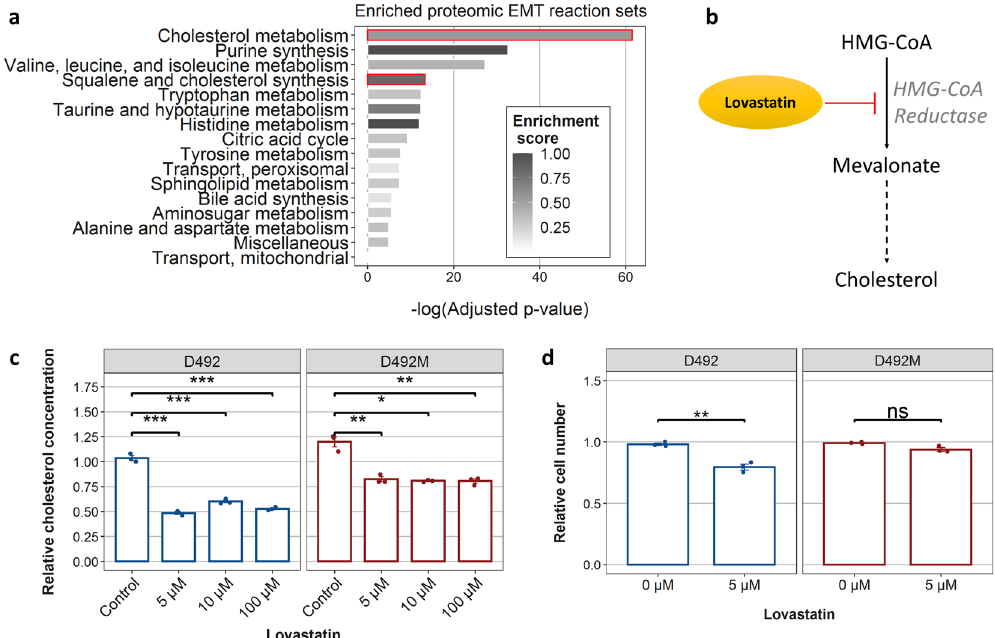
Fig. 4 Integrated analysis of all data-type based GSMMs reveals EMT-related differences in cholesterol metabolism. a Enrichment analysis of reactions that need alterations for the EPI to take on a MES fl ux phenotype in all proteomic GSMMs. This approach helps to identify reaction sets (i.e., families of pathways) which need to be altered for EMT-related changes in fl ux pro fi les. Reaction sets shown are ones with FDR- corrected p value less than 0.01. The scale (Enrichment score) represents the fraction of set reactions within the EMT reactions. The p values are FDR-adjusted p values from a hypergeometric test for enrichment of reaction sets. The two reaction sets highlighted in red are cholesterol- related. b The mechanism of inhibition of cholesterol synthesis by lovastatin. Dashed arrows represent more than one metabolic reaction. c Both D492 and D492M were treated with various concentrations of lovastatin, an inhibitor of cholesterol synthesis. The fi gure shows the cholesterol concentration in D492 and D492M cells after treatment with lovastatin. d Survival of D492 and D492M cells after treatment 5 µM concentration of lovastatin. Results in c) and d) are shown as mean + SEM from three experiments (shown with dots). Student ’ s t -test was used to estimate signi fi cance and p values were adjusted using the Benjamini – Hochberg